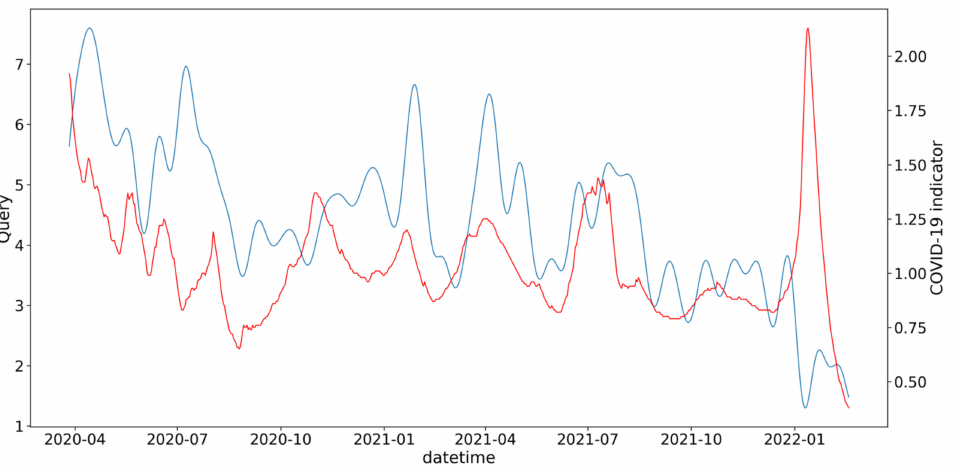
Figure 6. COVID-19 reproduction rate value (red line) and dynamics of publication activity on query “Vaccination, Vaccines, COVID” (blue